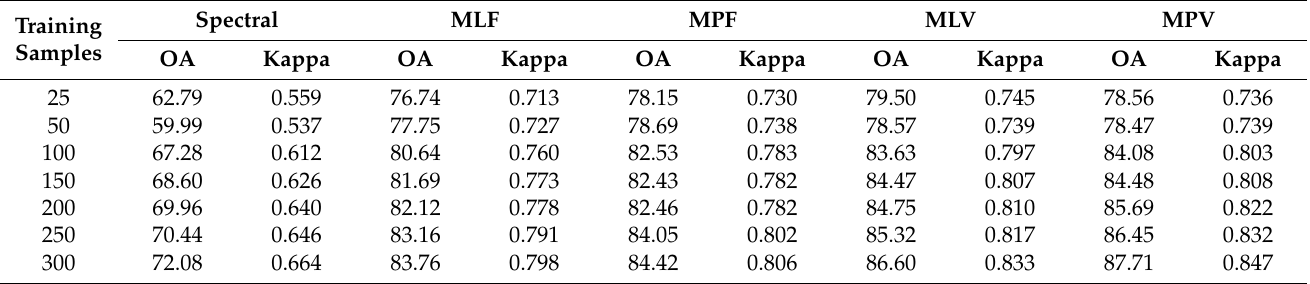
Table 9. OAs (%) and Kappa coefficients obtained by different methods for the Honghu dataset using RF with different numbers of training samples per